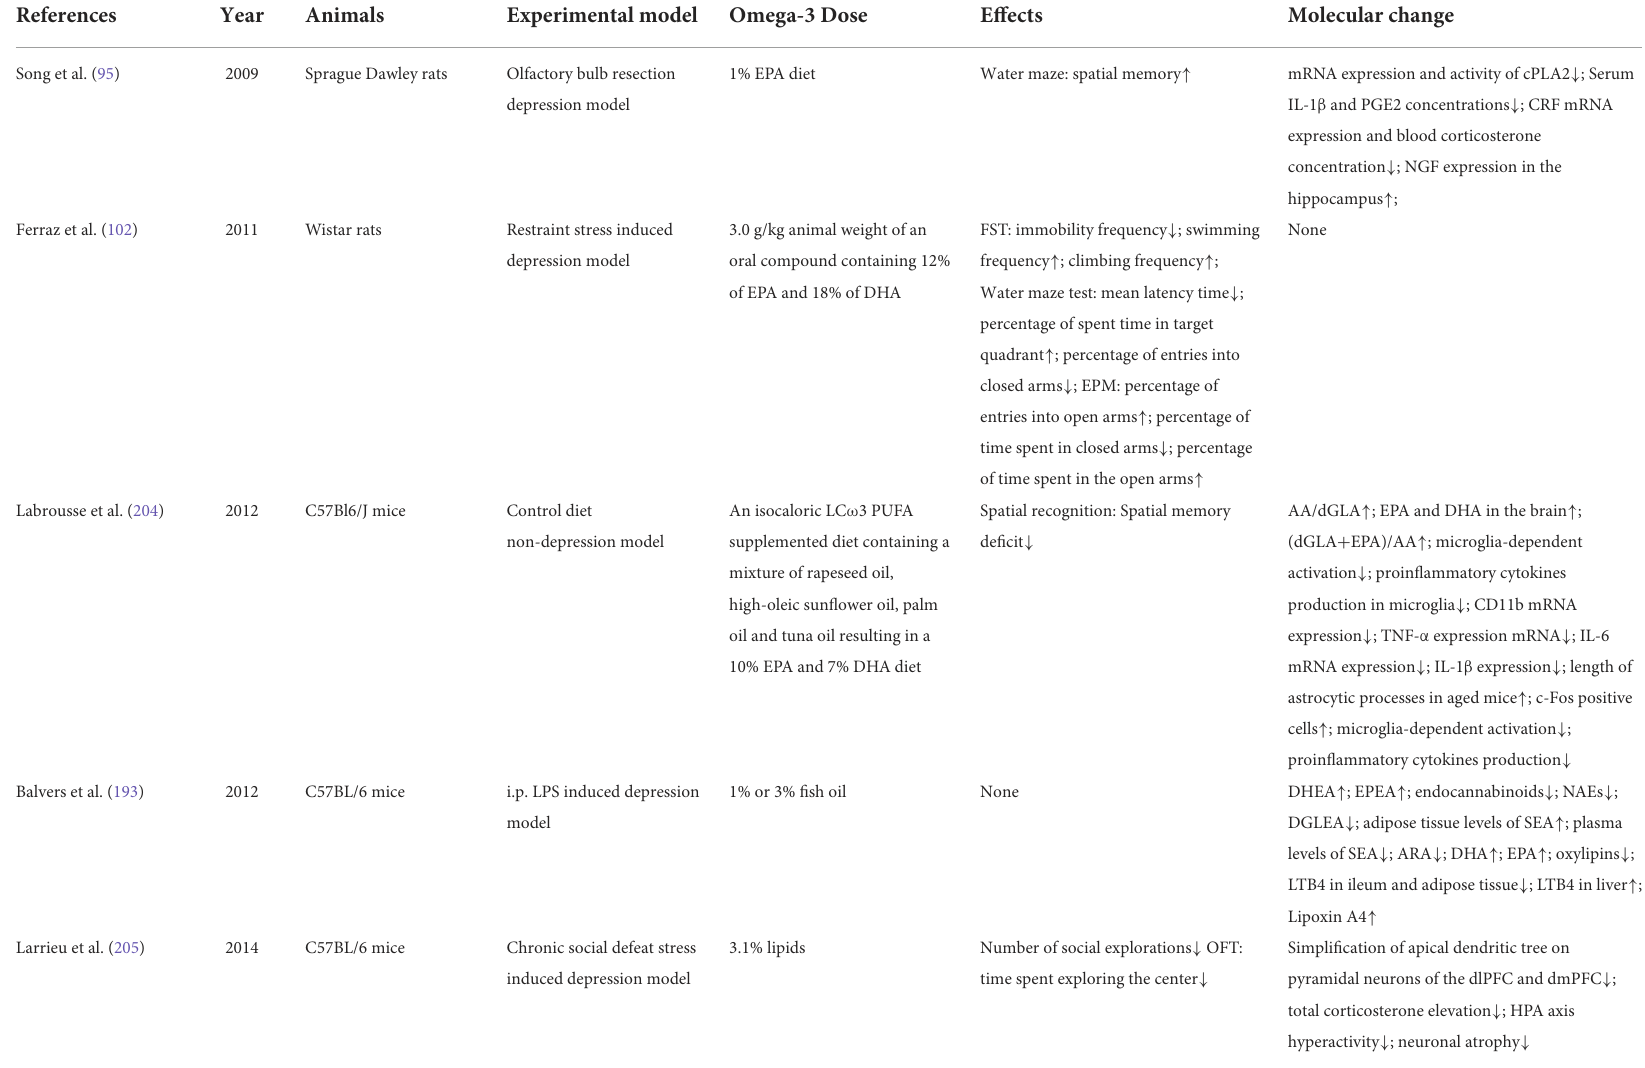
TABLE 1 Experimental design and results summary of animal studies in